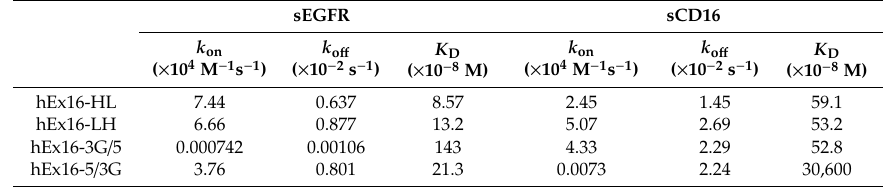
Table 1. Binding parameters of hEx16-Dbs obtained using surface plasmon resonance (SPR) spectroscopy.